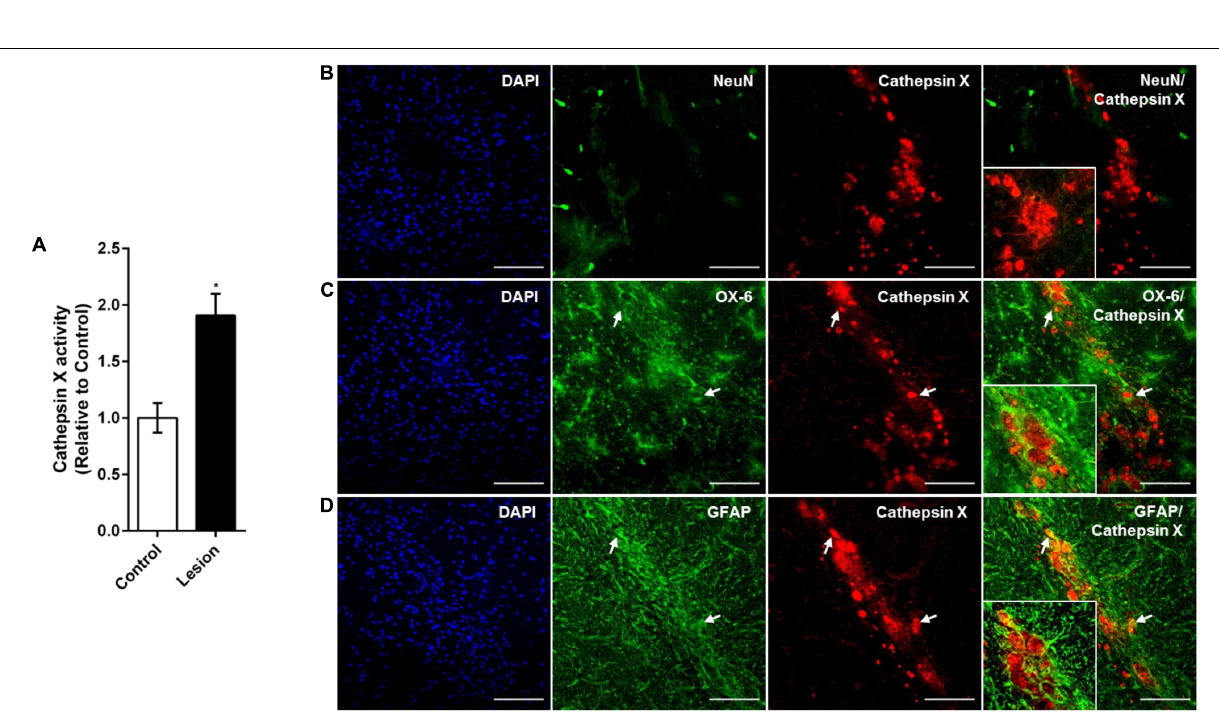
FIGURE 6 | Phenotype of increased cathepsin X-immunopositive cells in the ipsilateral SNc after long-term 6-OHDA injection. (A) Enzymatic activity analysis of cathepsin X in the SNc, dissected from the coronal sections from the 4 weeks’ time-point after 6-OHDA-induced lesion. Significantly increased cathepsin X activity in the ipsilateral SNc (Lesion) was observed, compared to that in the contralateral side (Control). Values are means ± SD of four experiments. ∗ P < 0.05 (B–D) Representative images of double immunofluorescence staining of cathepsin X (red fluorescence) and cell-type markers (green fluorescence) for of neurons (NeuN, B ), microglial cells (OX-6, C ) or astrocytes (GFAP, D ) in the ipsilateral SNc at 4 weeks after the 6-OHDA injection. Nuclei were counterstained with DAPI (blue fluorescence). Neuronal cells surrounding the site of injection were negative for cathepsin X expression. Increased cathepsin X expression in ipsilateral SNc was predominantly restricted to microglial cells ( C , white arrows) and some astrocytes ( D , white arrows). Groups of four animals ( n = 4) were analyzed and four sections of the SNc region of each animal were analyzed. Scale bars = 100 µ